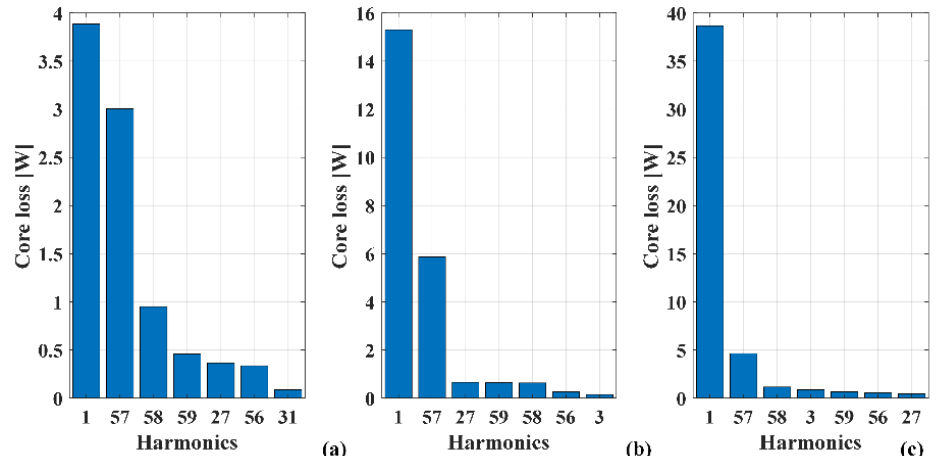
Figure 12. Analysis results of core loss according to magnetic flux density harmonics with PWM current applied to the stator winding: ( a ) stator shoe, ( b ) stator tooth, and ( c ) stator yoke.